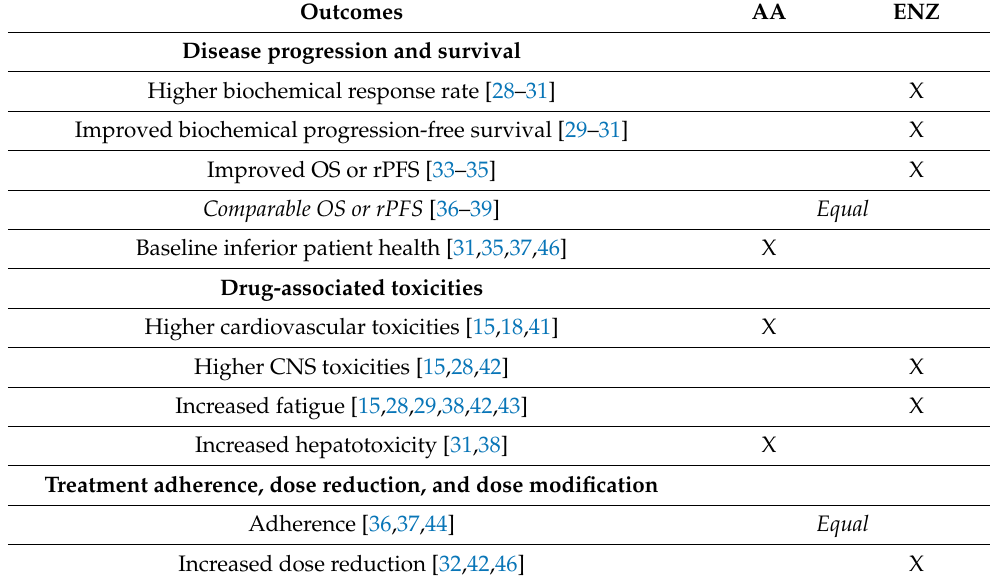
Table 3. Summary of